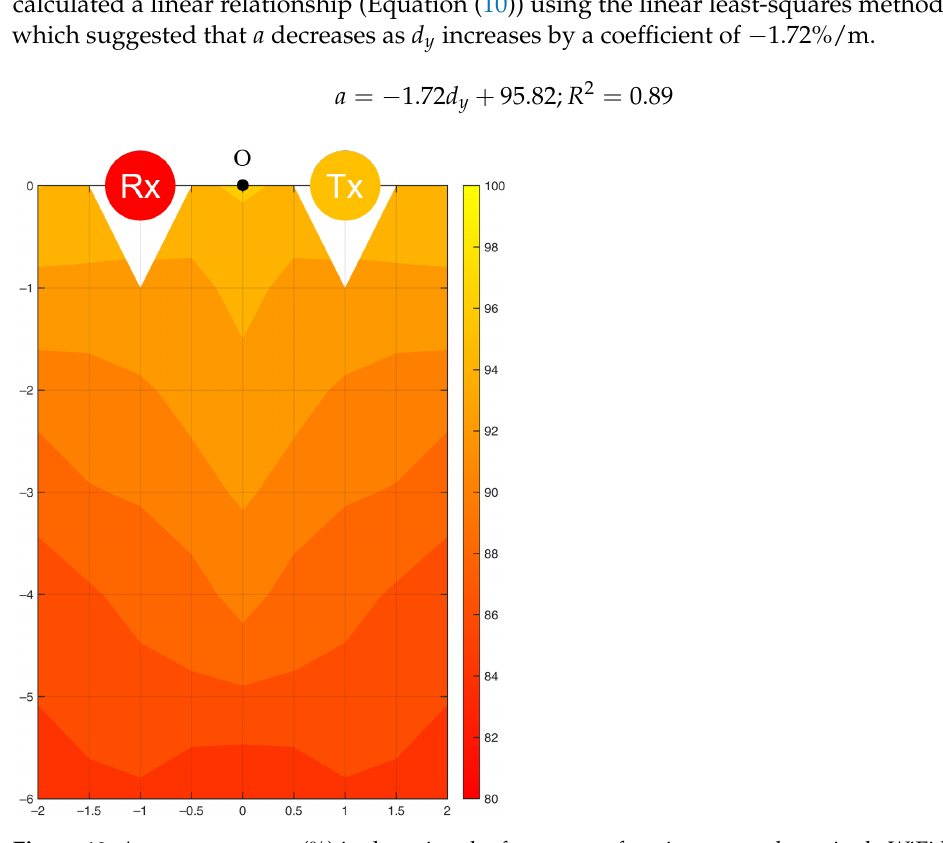
Figure 10. Accuracy contour (%) in detecting the frequency of resting tremor by a single WiFi